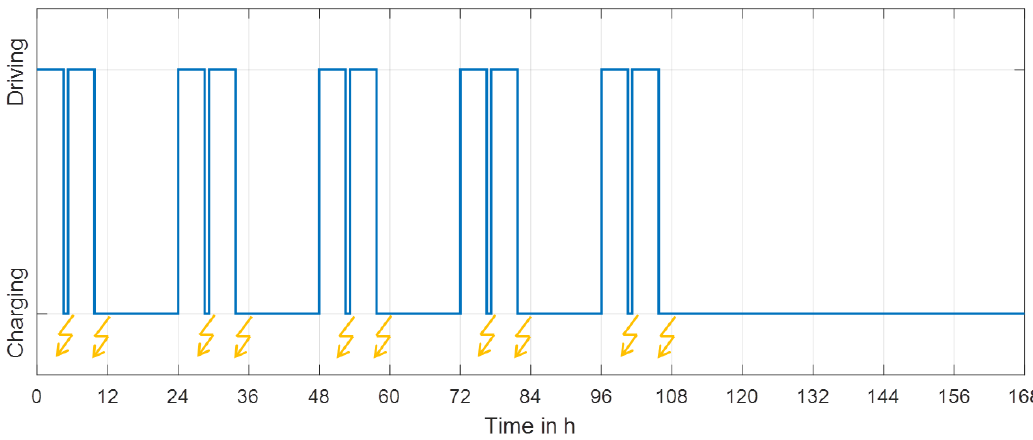
Figure 7. The weekly driving sequence for the battery electric truck consisting of 5 daily driving sequences and charging periods (beginning is marked by flash sign).